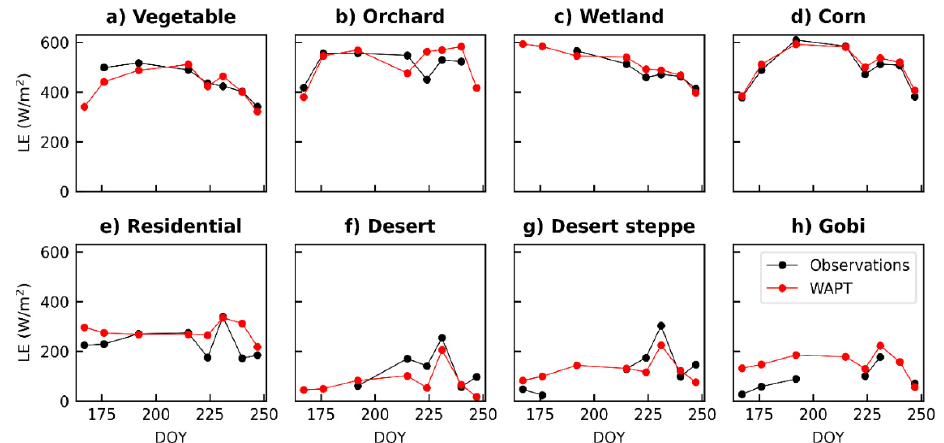
Figure 6. Performance of the WAPT model in 8 days (DOY167, DOY176, DOY192, DOY215, DOY224, DOY231, DOY240, DOY247) during months 6–9 in 2012 for vegetable ( a ), orchard ( b ), wetland ( c ), corn ( d ), residential ( e ), desert ( f ), desert steppe ( g ) and Gobi ( h ), respectively. The observations and the WAPT model results are presented with black and red lines, respectively. Table 5. Statistics of the modeling LE accuracies during months 6–9 in 2012.